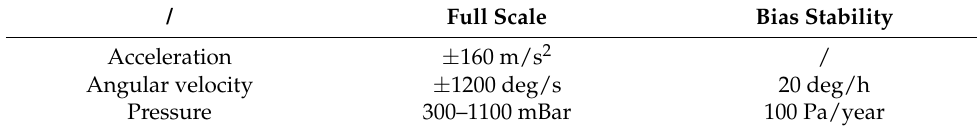
Figure 9. Appearance and installation configuration of MTW suit: ( a ) sensor appearance and object coordinate system; and ( b ) four-node inertial sensor network configuration. Table 1. Parameters of MTW.